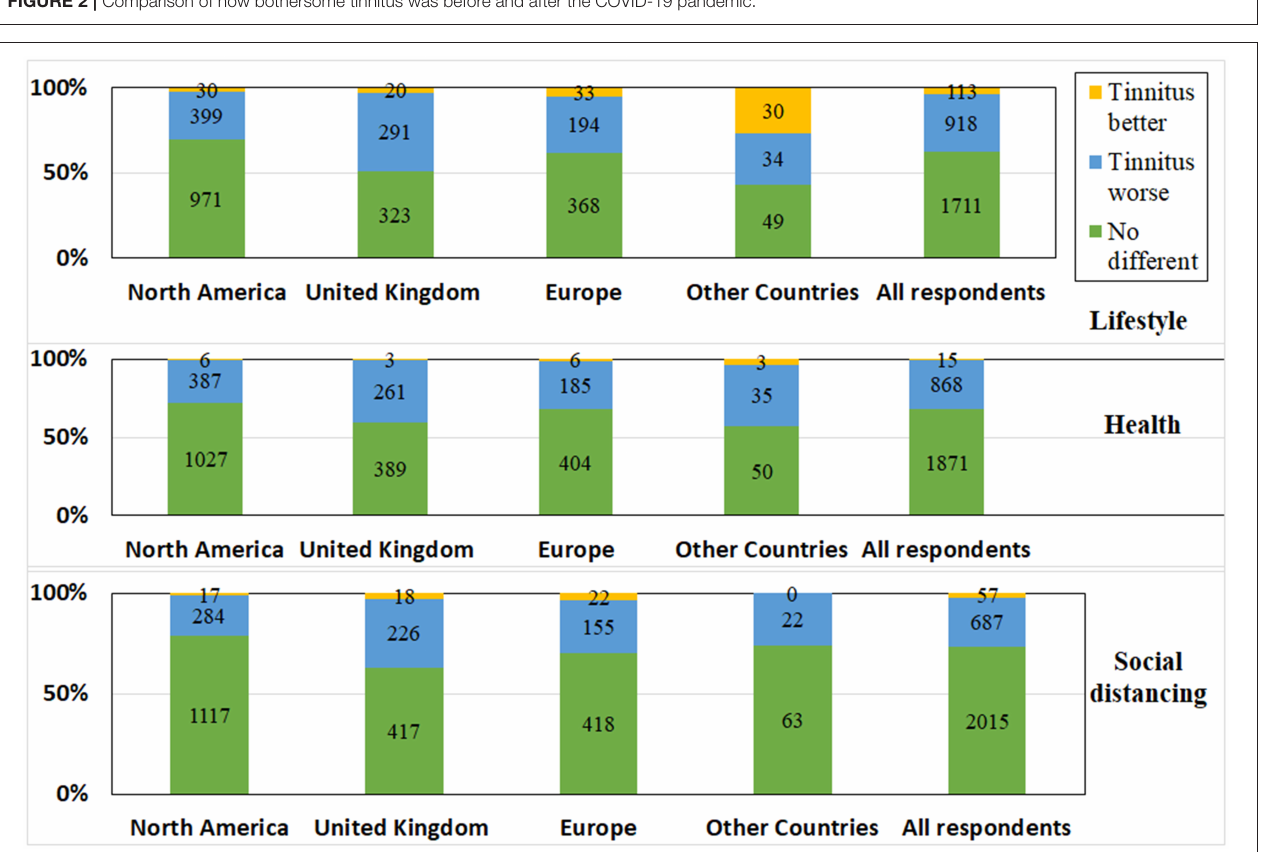
FIGURE 3 | The impact of lifestyle changes, social distancing restrictions, and health concerns during the pandemic on tinnitus experiences.